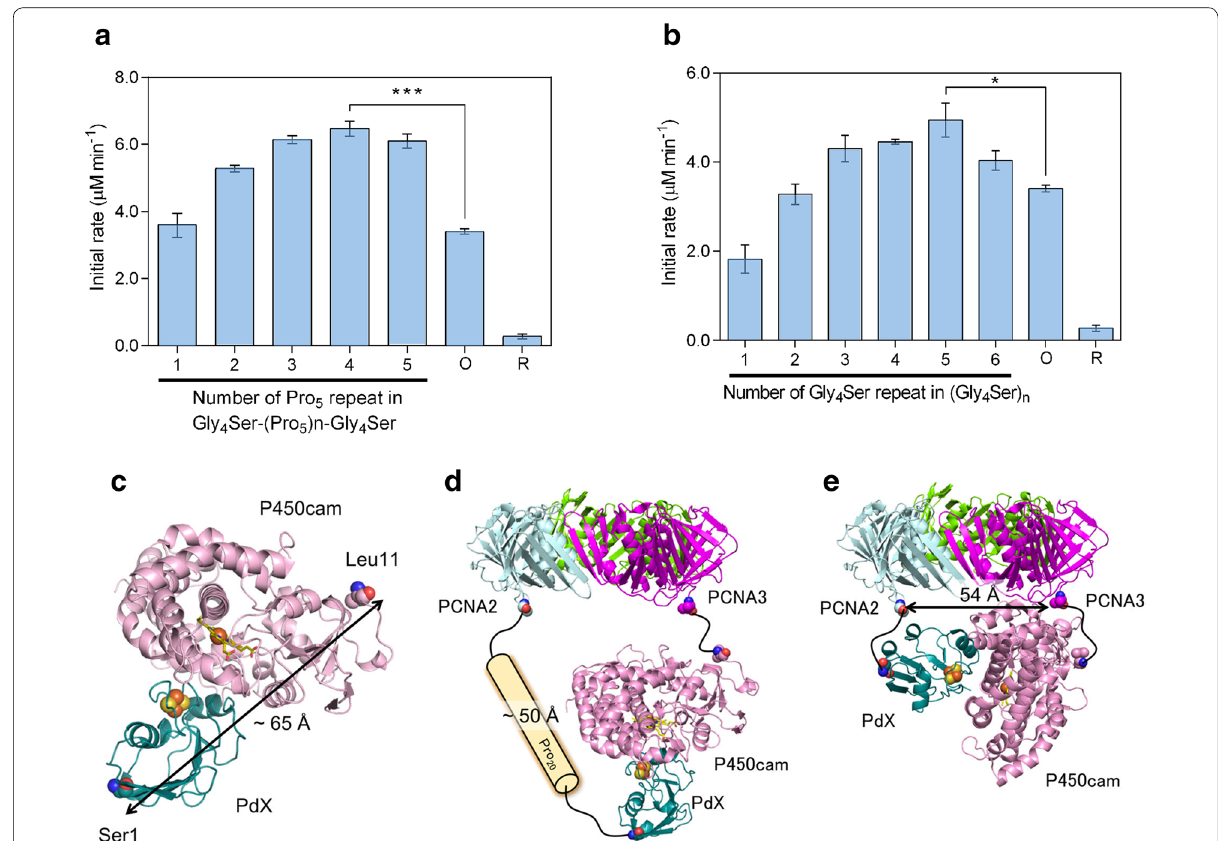
Fig. 27 Optimization of the PCNA2-PdX fusion protein linker in PUPPET. a P450cam oxidation activities of the PUPPET linker variants, PUPPET-Pn (n 1–5). b P450cam oxidation activities of the PUPPET linker variants, PUPPET-Gn (n = arrangement of P450cam and the PCNA ring when the PdX-binding site of P450cam faces in the same direction to the PCNA ring. e Spatial arrange- ment of P450cam and the PCNA ring when the PdX-binding site of P450cam faces in a perpendicular direction to the PCNA ring (Figures repro- duced from Ref.